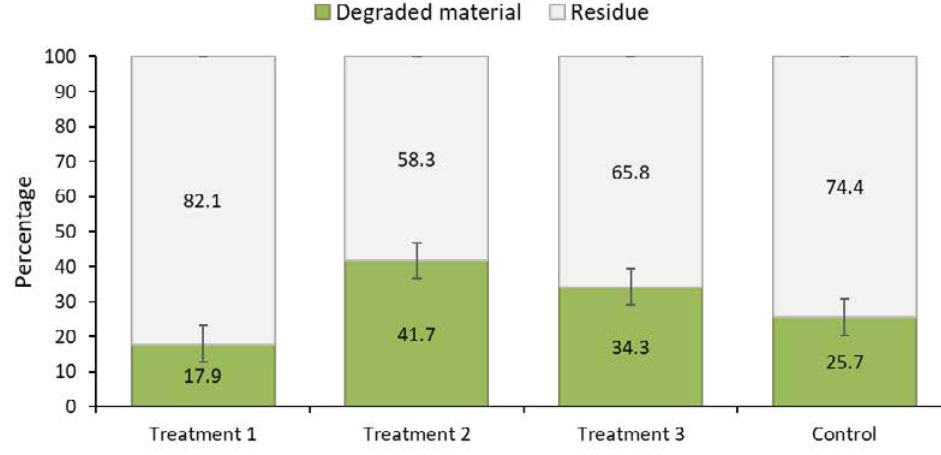
Fig. 1: Percentage of degraded material vs Residue per treatment